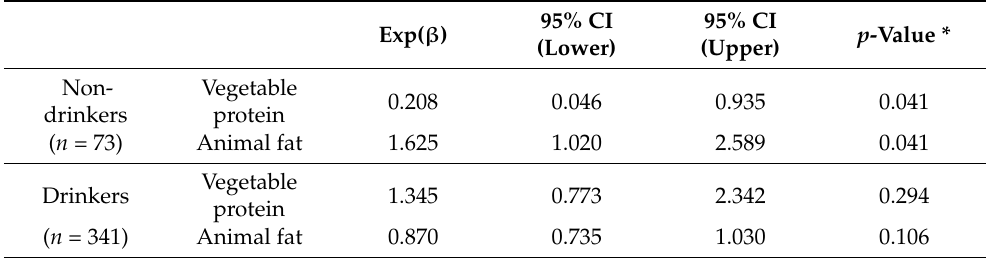
Table 4. Prospective relationship between nutrient intake and diabetes incidence according to drinking